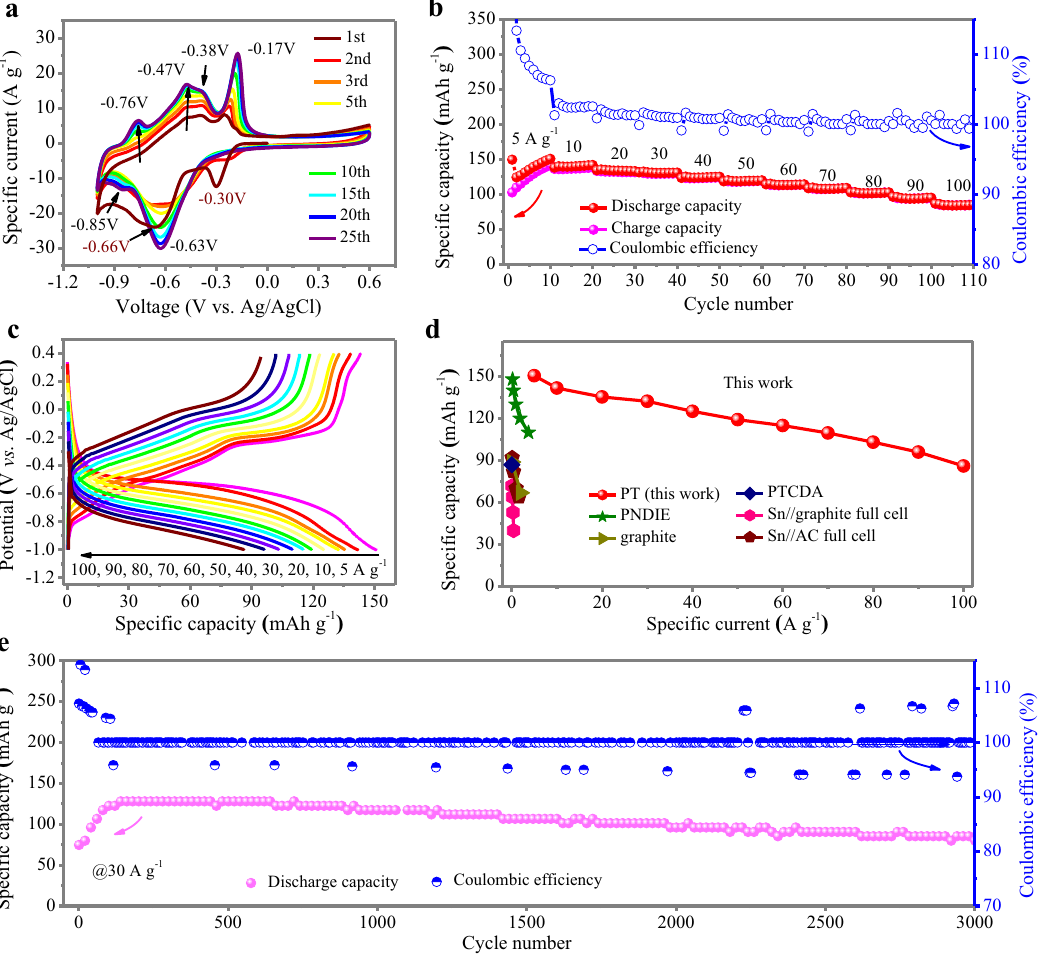
Fig. 2 Electrochemical performance of the PT anode in a three-electrode cell. a CV curves of PT anode in 1M CaCl 2 solutions at 20 mV s − 1 . b Speci fi c capacities of PT in 1M CaCl 2 at different speci fi c currents and the corresponding Coulombic ef fi ciencies. c GCD curves of PT in 1M CaCl 2 at different speci fi c currents. d Capacity and rate ability comparison with reported anodes for CIBs. See Supplementary Table 2 for reported data in literature. e Cycling stability and Coulombic ef fi ciency of PT in 1M CaCl 2 at 30 A g − 1